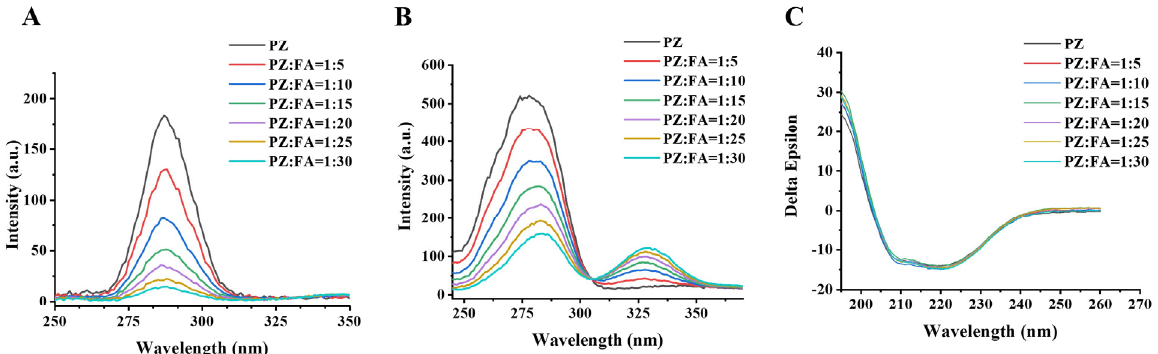
Figure 4. Synchronous fluorescence spectra of PZ (4 M) in the presence of FA with various molar ratios. ( A ) Δλ = 15 nm; ( B ) Δλ = 60 nm. Conditions: λ Ex = 200 nm, slits for excitation and emission of 10 and 5 nm, respectively, 4 µ M PZ, 20–120 µ M FA, 50.0 mM sodium citrate buffer, pH 4.2, and 25 °C; ( C ) CD spectra of PZ in the presence of FA with various molar ratios. Conditions: the molar ratios of PZ (0.1 mg/mL, in 25.0 mM PB buffer, and pH 4.2) to FA varied from 1:5 to 1:30.